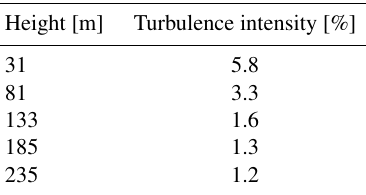
Table 2. Turbulence intensity as a function of height for the extreme low-level jet case.